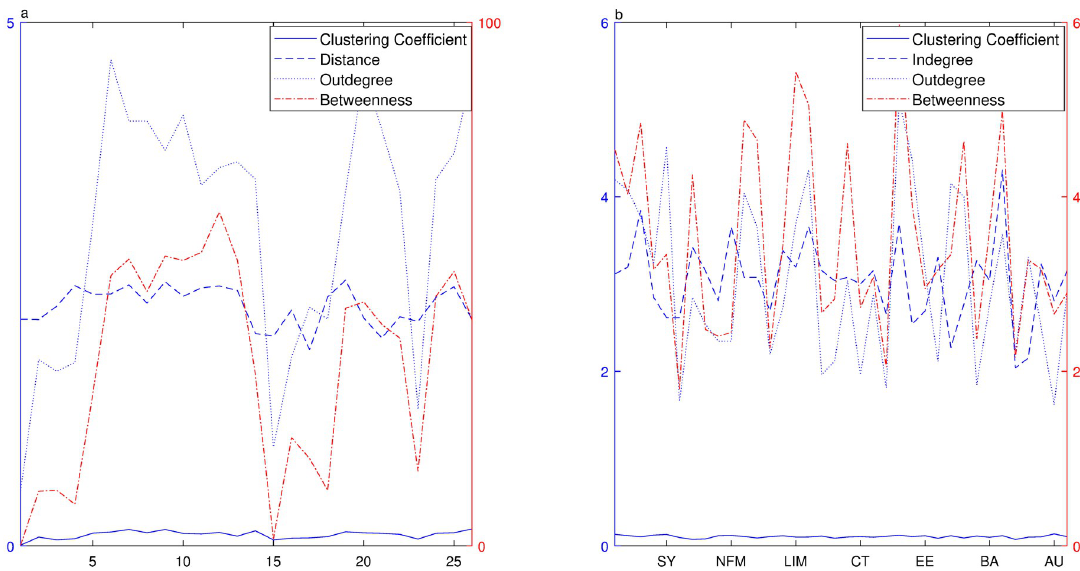
Fig 7. Network topology of region index over rolling windows. a Shows distributions of the clustering coefficient(solid curve), the distance(dashed curve), the outdegree(dotted curve) and the betweenness(dash-dot curve) over different periods where the clustering coefficient, distance and outdegree are referred to the left Y-axis and average betweenness is referred to the right Y-axis. b Shows distributions of clustering coefficient(solid curve), indegree(dashed curve), outdegree(dotted curve) and betweenness(dash-dot curve) for each industry sector during the whole period where the clustering coefficient, the indegree and the outdegree are referred to the left Y- axis and the betweenness is referred to the right Y-axis.